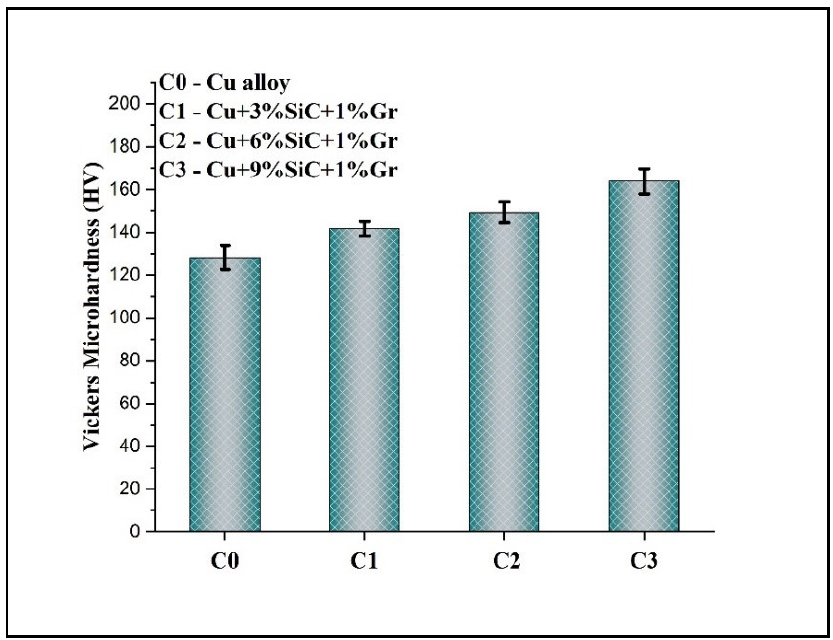
Figure 9. Variation of Vickers micro-hardness Cu alloy and Cu-(3, 6, 9) wt.% SiC-Gr hybrid composites.